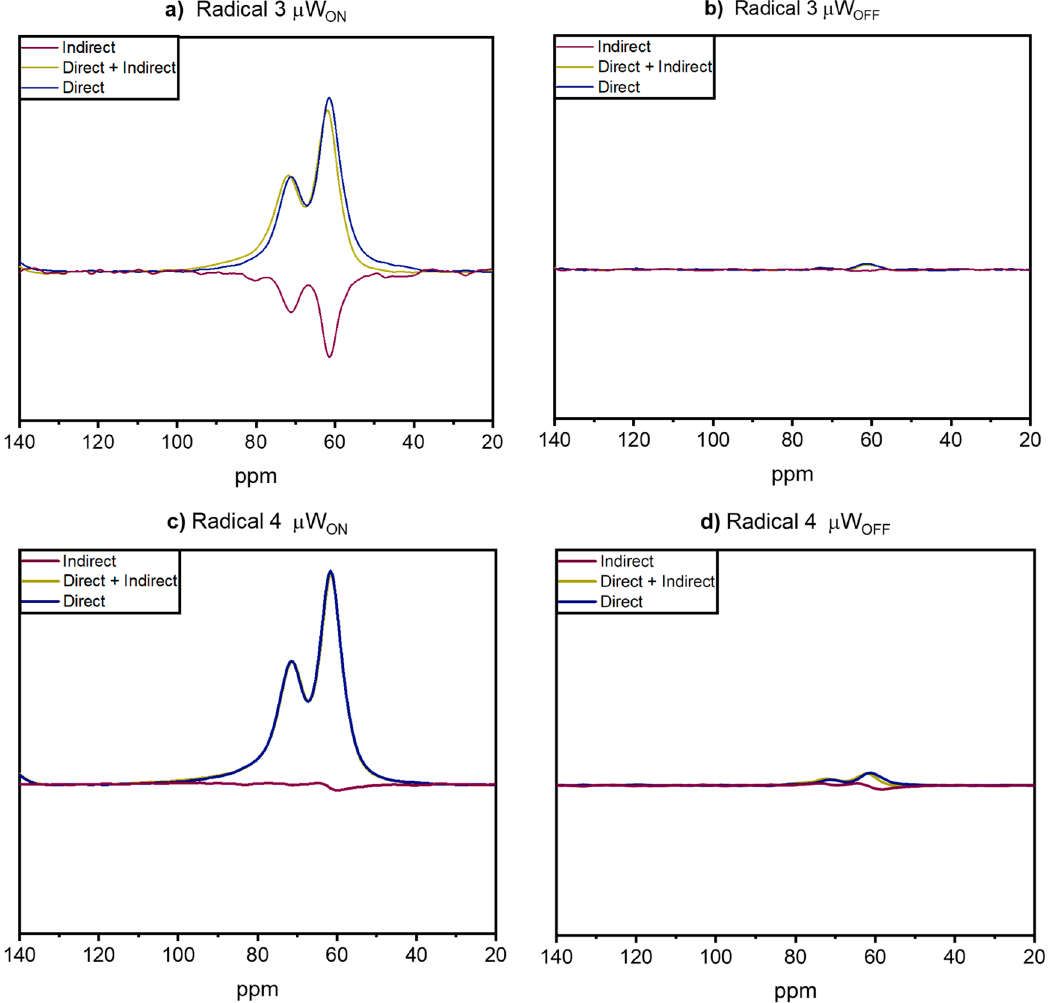
Figure 5. A 13 C MAS spectra of frozen solutions of 15 mM binitroxyl radicals 3 and 4 , respectively, in glycerol-d 8 /D 2 O/H 2 O (60:30:10 v / v / v ) obtained with 300 s as build-up. ( a ) Radical 3 measured with MW irradiation (MW ON ), ( b ) radical 3 measured without MW irradiation (MW OFF ), ( c ) radical 4 with MW irradiation (MW ON ), and ( d ) radical 4 without MW irradiation (MW OFF ). Spectra were recorded at nominally 115